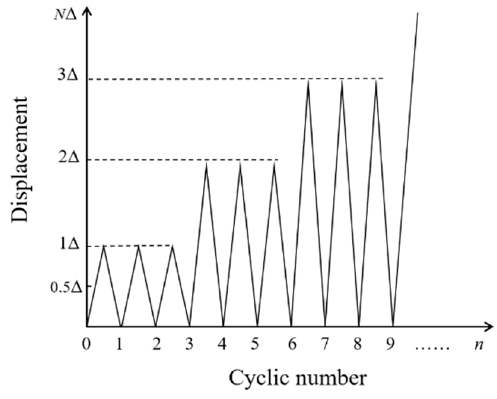
Figure 6. Scheme of loading.